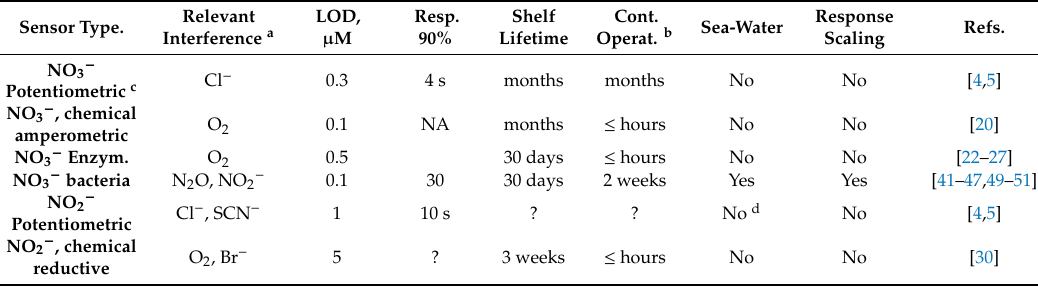
Table 1. Critical characteristics of various sensor